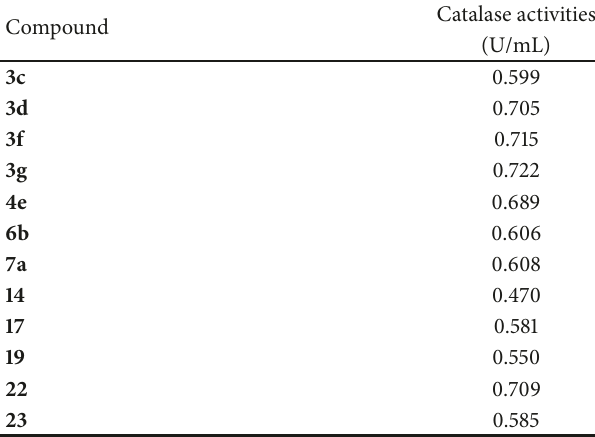
Table 3: Antibacterial activity of the compound determined by serial dilution method.